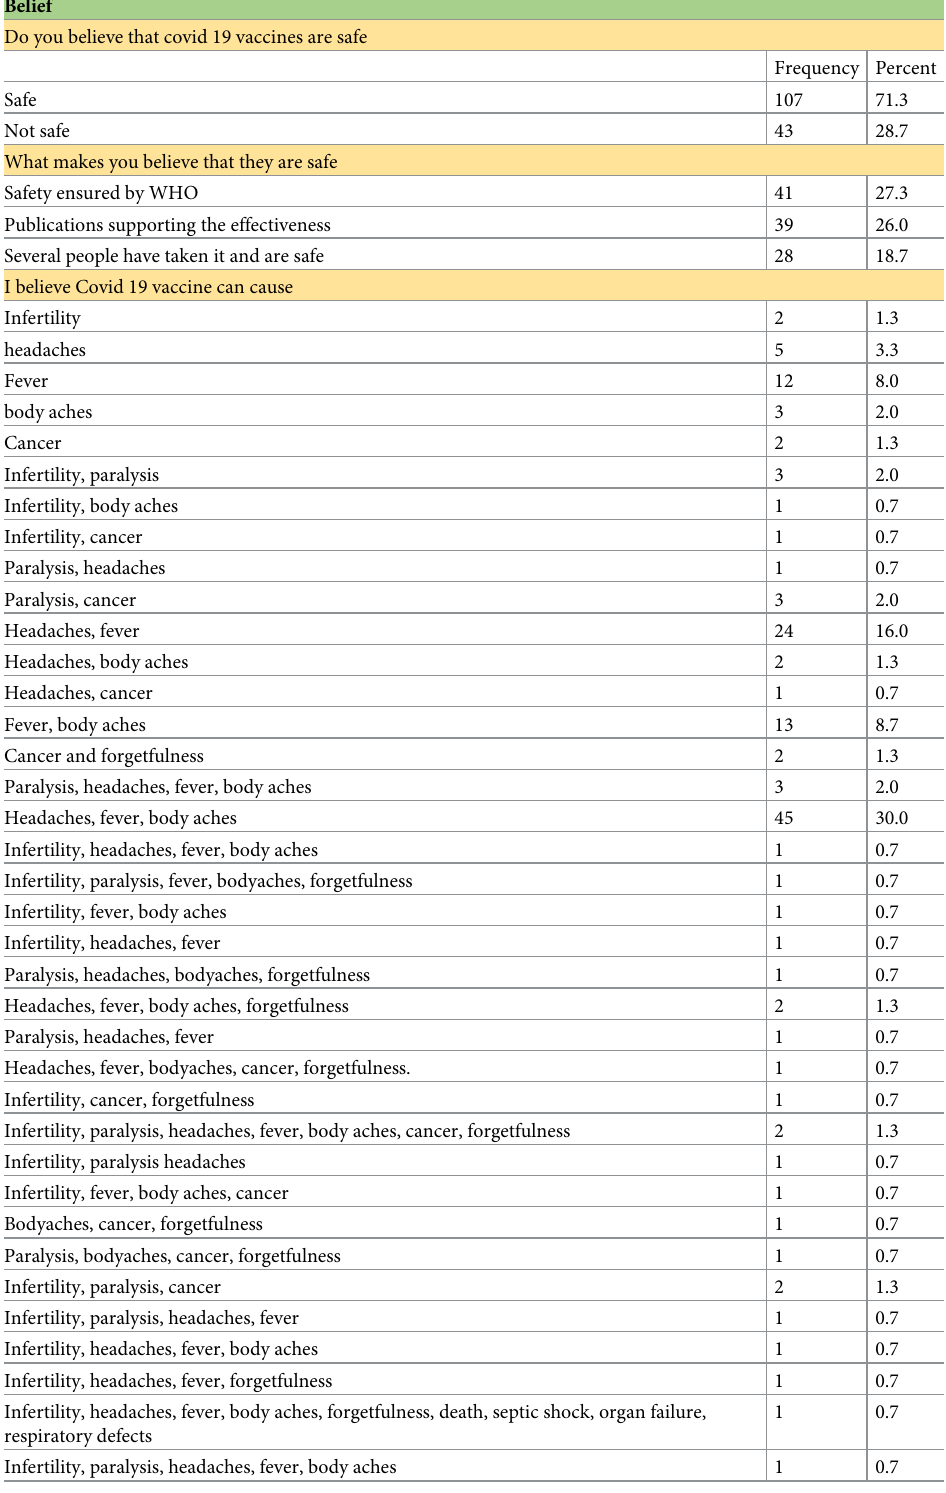
Table 3. Responses related to